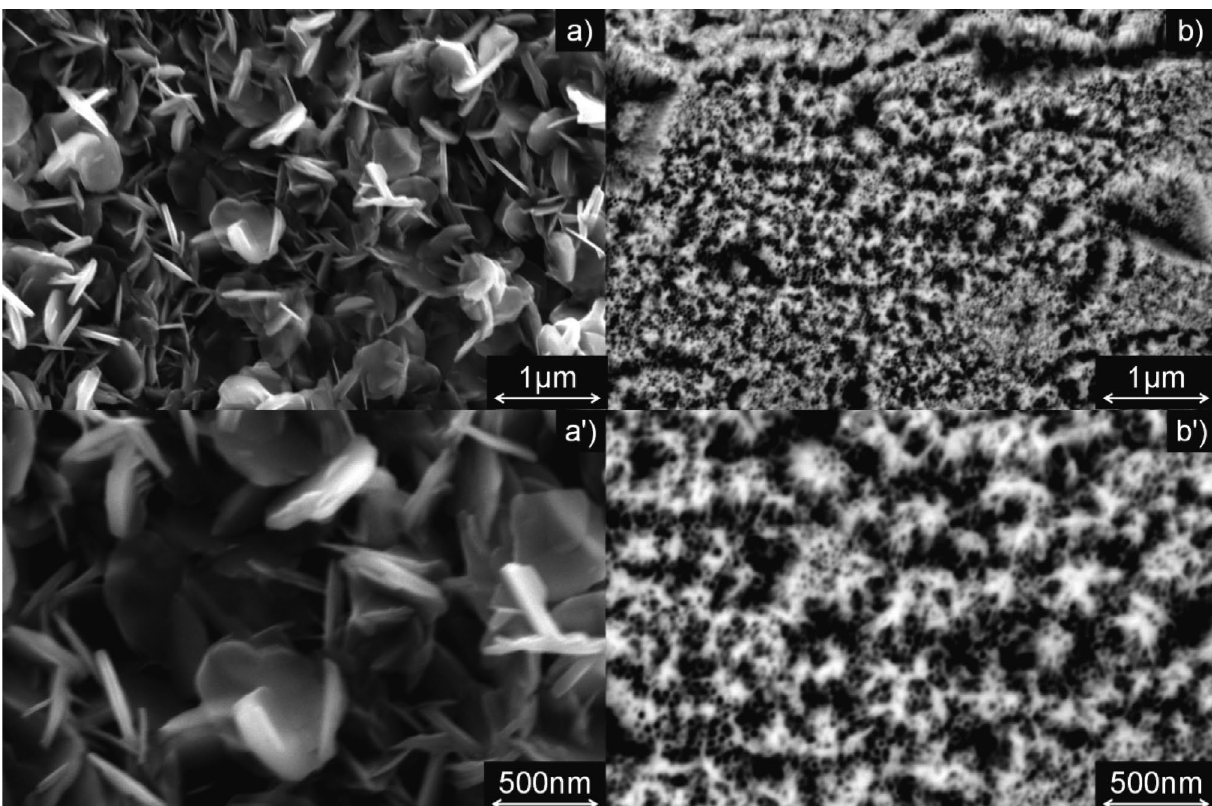
Fig. 3 SEM micrographies for Zr samples anodized at 45 V in a), a’) E1; b), b’)